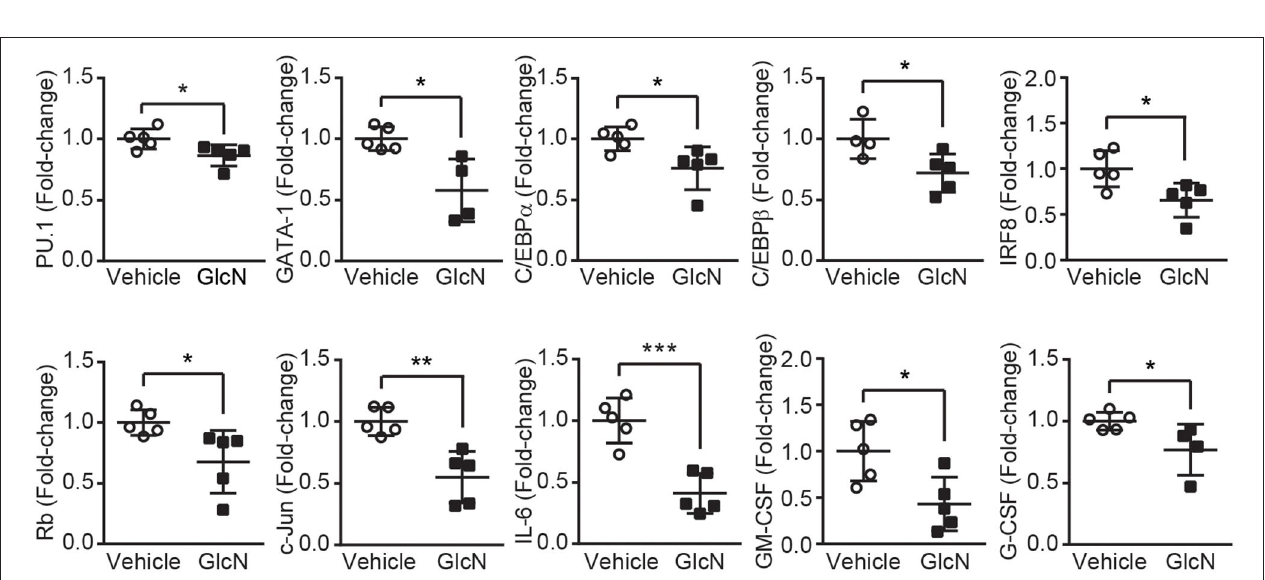
FIGURE 5 | GlcN suppresses the expression of transcriptional factors and cytokines involved in myelopoiesis. Relative mRNA expression of PU.1, GATA1, C/EBP α , C/EBP β , IRF8, Rb, c-Jun, IL-6, GM-CSF, and G-CSF in the BM cells of GlcN-treated mice were determined by quantitative reverse transcription-PCR. The quantified results are presented as the mean ± standard deviation. * P < 0.05; ** P < 0.01; *** P < 0.001.